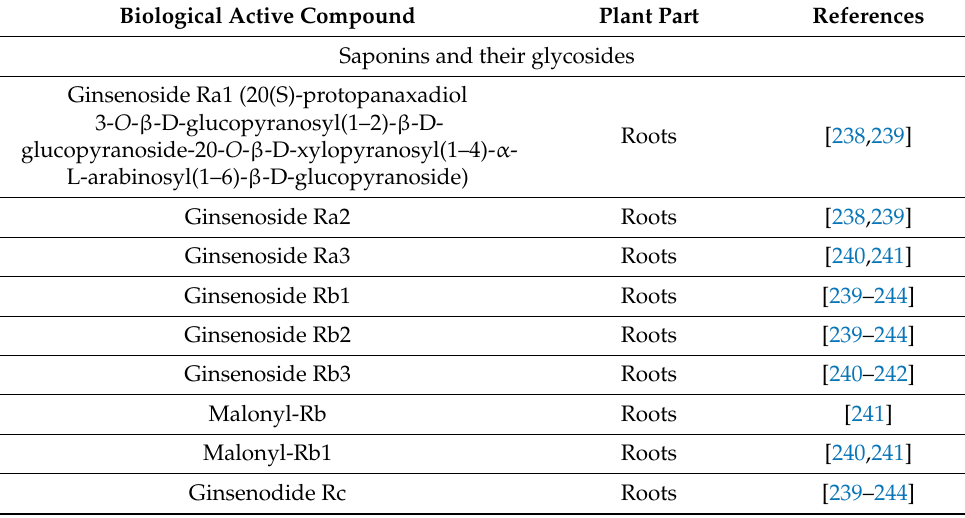
Table 5. Bioactive compounds in Panax ginseng